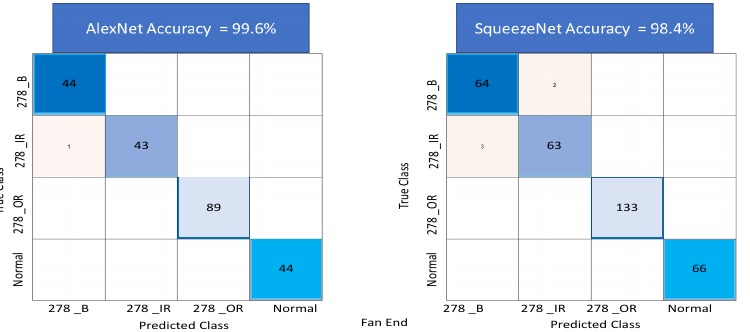
Figure 17. Figure showing Confusion Matrix for AlexNet and SqueezeNet using Transfer learning on the Color recurrence plots for the data set corresponding to the fan end bearing subset of the data